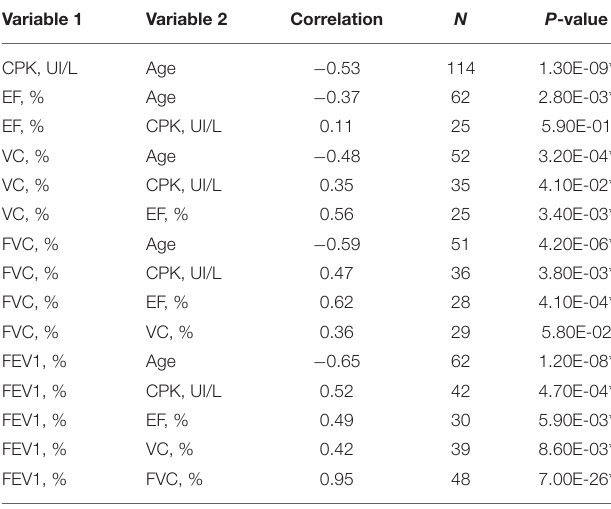
TABLE 3 | Correlation between